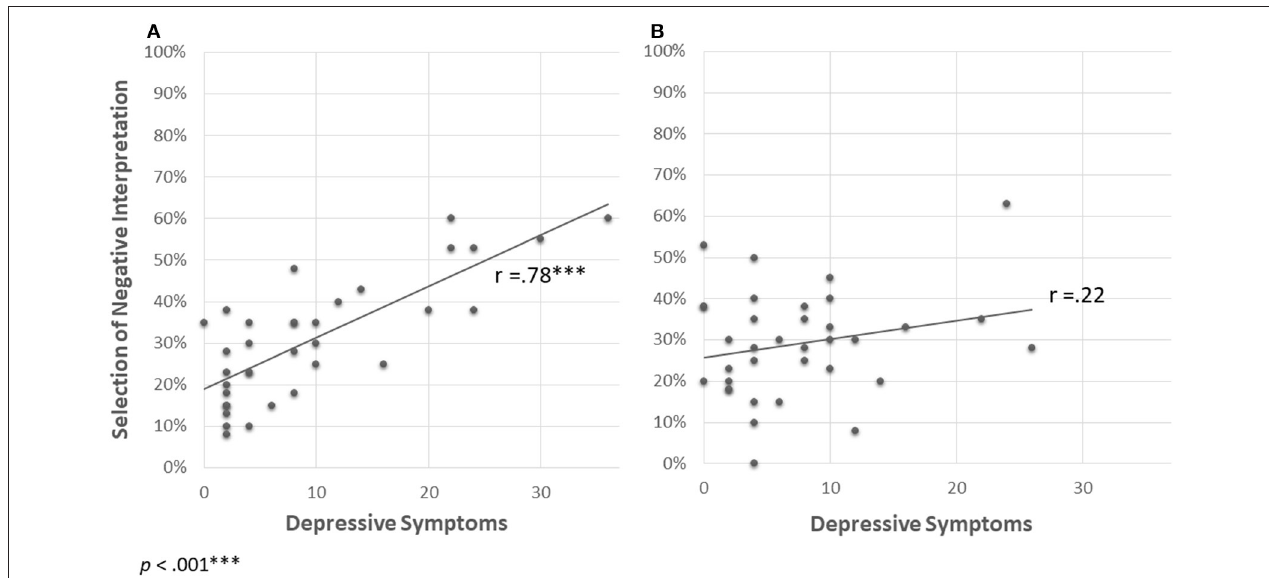
FIGURE 2 | Prediction of selecting negative interpretation by levels of depression symptoms in each social experience condition [ (A) ostracism, (B) overinclusion].